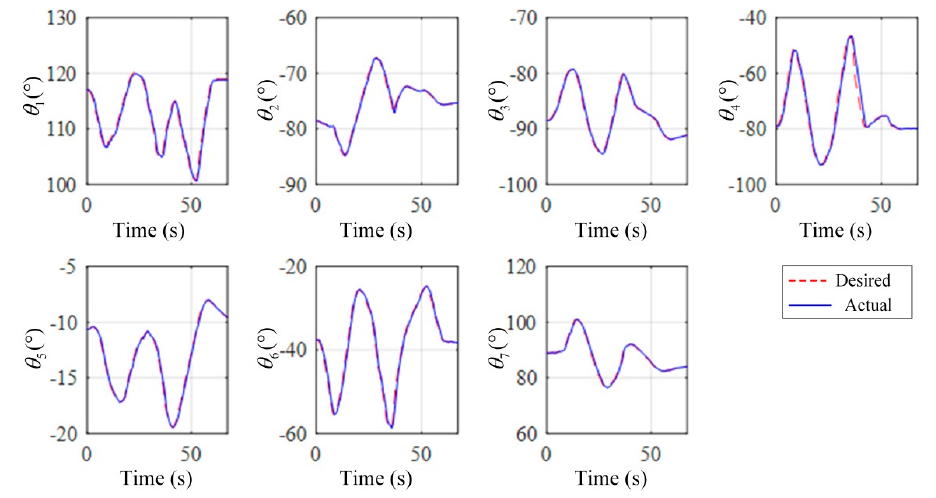
Figure 12. Trajectory tracking results with fixed scale mapping.